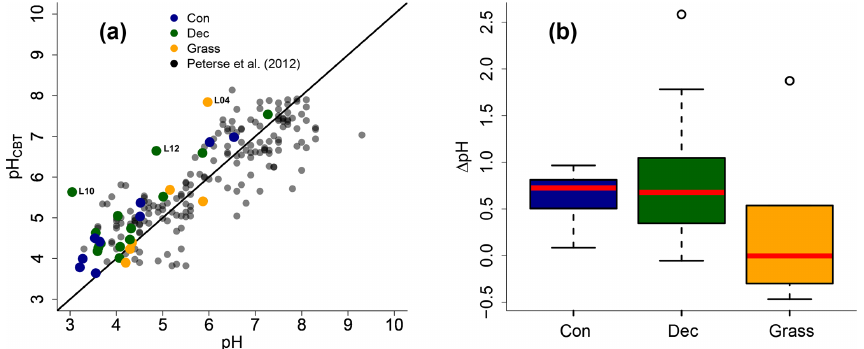
Figure 5. (a) Correlation between measured pH and reconstructed soil pH (pH CBT ) from our transect data in comparison to the global calibration dataset from Peterse et al. (2012) ( R 2 = 0 . 7, RMSE = 0.75, n = 176). The black line indicates the 1:1 relationship. (b) Box plots of (cid:49) pH (refers to pH CBT –pH). Box plots show the median (red line), interquartile range (IQR) with the upper (75%) and lower (25%) quartiles, lowest whisker still within 1.5 IQR of the lower quartile, and highest whisker still within 1.5 IQR of the upper quartile; dots mark outliers. Abbreviations: con: coniferous forest sites ( n = 9); dec: deciduous forest sites ( n = 14); grass: grassland sites ( n = 6).